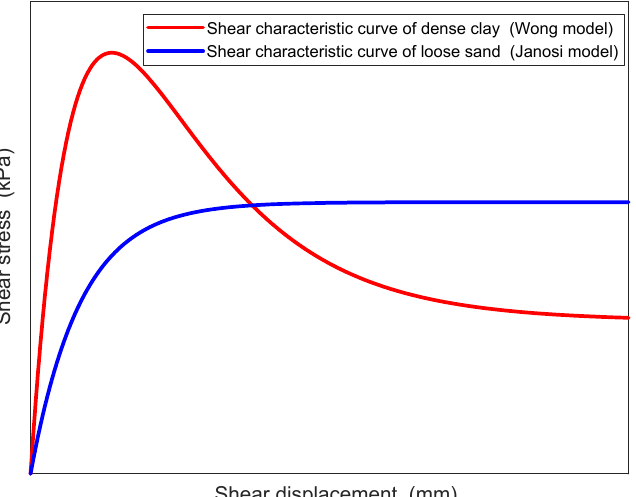
Figure 5. Schematic of the shear characteristic curve of the track segment. The red curve is derived from Wong’s [32,33] model. The blue curve is derived from Janosi’s model [34].